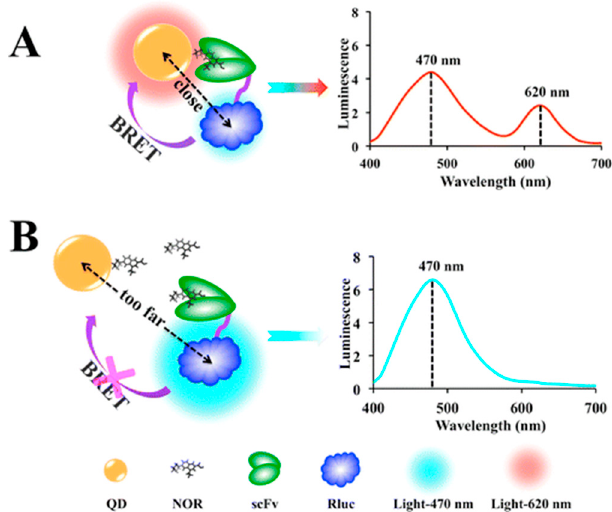
Figure 5. ( A ) In the absence of free FQs, QD-NOR is recognized by scFv-Rluc and the Rluc and QDs are in close proximity; energy is released from the substrate and transferred to the QDs via BRET. ( B ) In the presence of free FQs, the scFv-Rluc binds to the free FQs and the distance between the Rluc and QDs is too far to realize energy transfer. Reprinted with permission from [57]. Copyright 2016 American Chemical Society.